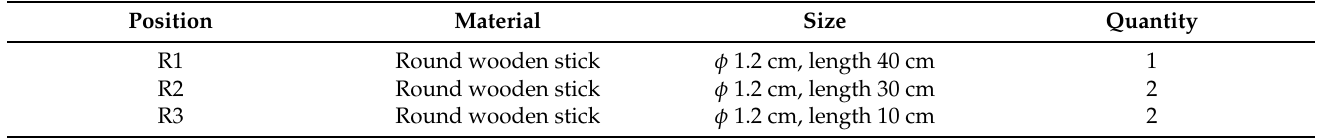
Table 1. The sticks of the materials for the developed arm. “Position” is shown in Figure